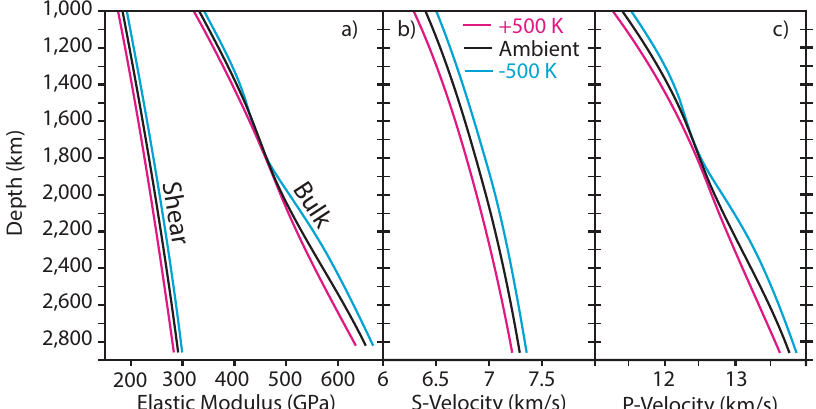
Fig. 2 Depth dependence of elastic moduli and seismic velocities for pyrolite composition listed in Table 1 15 . a Shear and bulk moduli. The anomalous behaviour of the bulk modulus, K 11 ( K = − V ( dP / dV ), where V is volume and P is pressure) is due to the iron octahedron volume collapse during the spin- state change 4 associated with the spin crossover. As previously shown 11 , the pressure onset, the pressure range of the HS-LS crossover, and associated anomalies in K are temperature dependent (same legend all panels). The shear modulus, G, ( G = τ / γ , where τ is the shear stress and γ is the shear strain) is not signi fi cantly affected by the octahedron volume reduction and increases monotonically with increasing pressure and decreasing temperature. b S-wave ffiffiffiffiffiffiffiffiffiffiffiffiffiffiffiffiffiffiffiffiffiffiffiffiffiffiffiffi p ð K þ 4 = 3 G Þ = ρ ) velocity for pyrolite at different temperatures. The average mantle temperature pro fi le (black) is calculated by setting the starting temperature to 1873 K at 660 km, and integrating the adiabatic temperature gradient 15 through the lower mantle. The blue/magenta curves were calculated using the same technique, but decreasing/increasing the temperature at 660 km by ±500 K. In the mixed-spin region, the softening of K 11 causes a reduction in P-wave velocity sensitivity to isobaric temperature variations 14 , while the S-wave velocity remains sensitive to such temperature variations. Consequently, the expected seismic signal of iron-bearing Fp in the lower mantle consists of a disruption of vertically coherent thermal structures in P-velocities, whereas a coherent thermal structure is apparent in the S-velocities 12,14 . Additional compositions shown in Supplementary Fig. 1 demonstrate the calculated seismic velocities dependence on Fp proportion. Table 1 Compositions in mol.% used in this paper